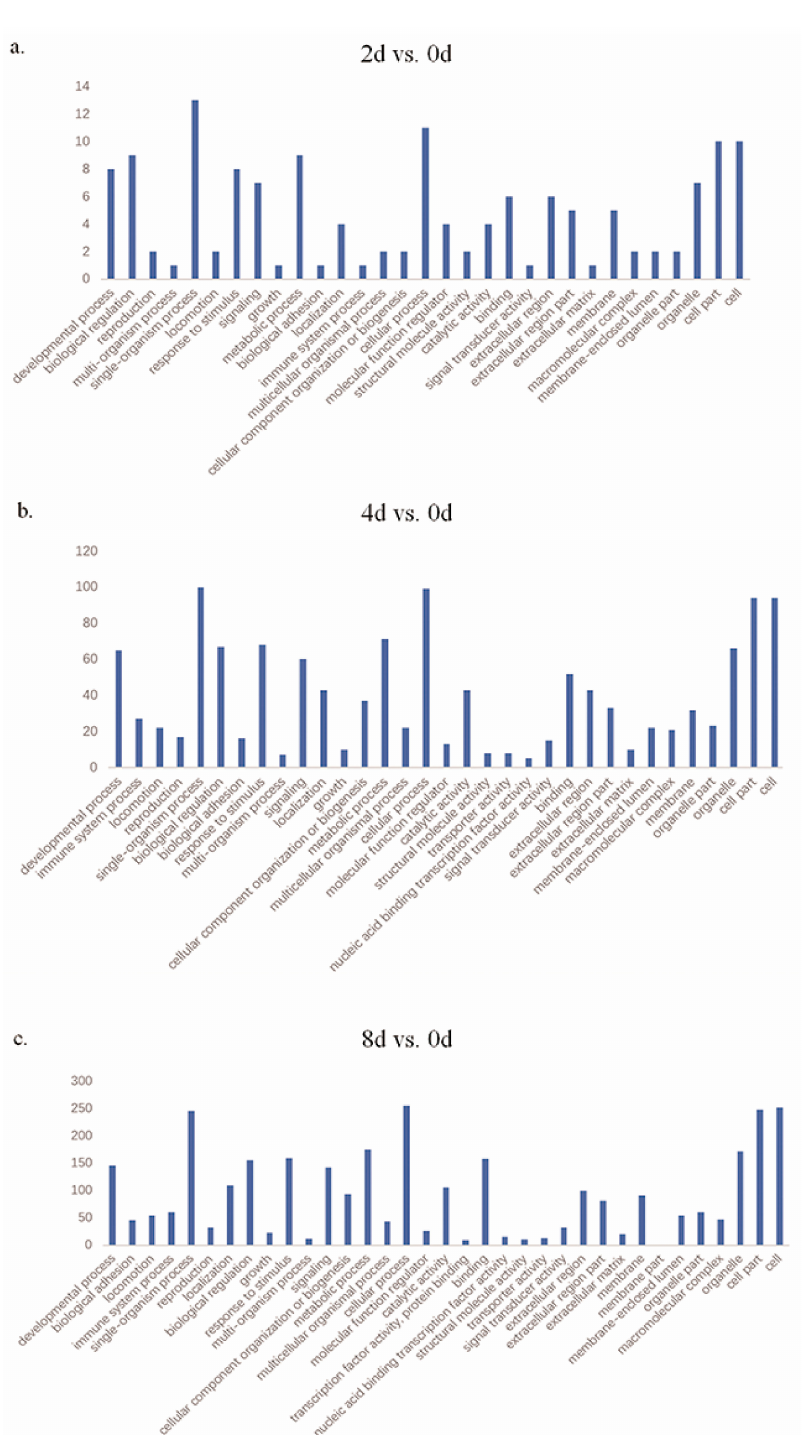
Figure 3. Gene Ontology (GO) functional enrichment analysis of DEGs at di ff erent stages. ( a ) GO terms overrepresented among DEGs between days 2 and 0. ( b ) GO terms overrepresented among DEGs between days 4 and 0. ( c ) GO terms overrepresented among DEGs between days 8 and 0. The results are summarized in the following three main categories: biological process, molecular function, and cellular component. The x -axis indicates functional groups. The y -axis indicates number of